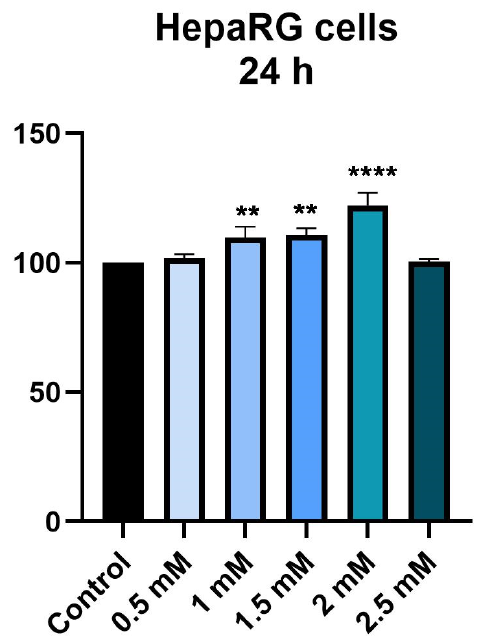
Figure 1. In vitro assessment of the effect of Met (0.5, 1, 1.5, 2 and 2.5 mM) exerts on the viability of HepaRG after 24 h of treatment. The data are expressed as viability percentages (%) normalized to control cells and expressed as mean values ± SD of three independent experiments performed in triplicate. To identify the statistical differences between the Control and the Met-treated group, a one-way ANOVA analysis was conducted followed by the Dunnett’s multiple comparisons post- test (** p < 0.01; **** p < 0.0001). At the 72 h time interval, the same trend is observed in terms of influencing cell viability. Thus, at the first four concentrations tested (0.5, 1, 1.5 and 2 mM) there is an increase in cell viability depending on the concentration, while at a concentration of 2.5 mM there is a decrease in cell viability compared to the first concentrations tested; however, the value of cell viability was higher than that of the control group, with the viability being approximately 100% in this case. However, the highest value of cell viability was recorded at a concentration of 2 mM, being about 171% (Figure 2).